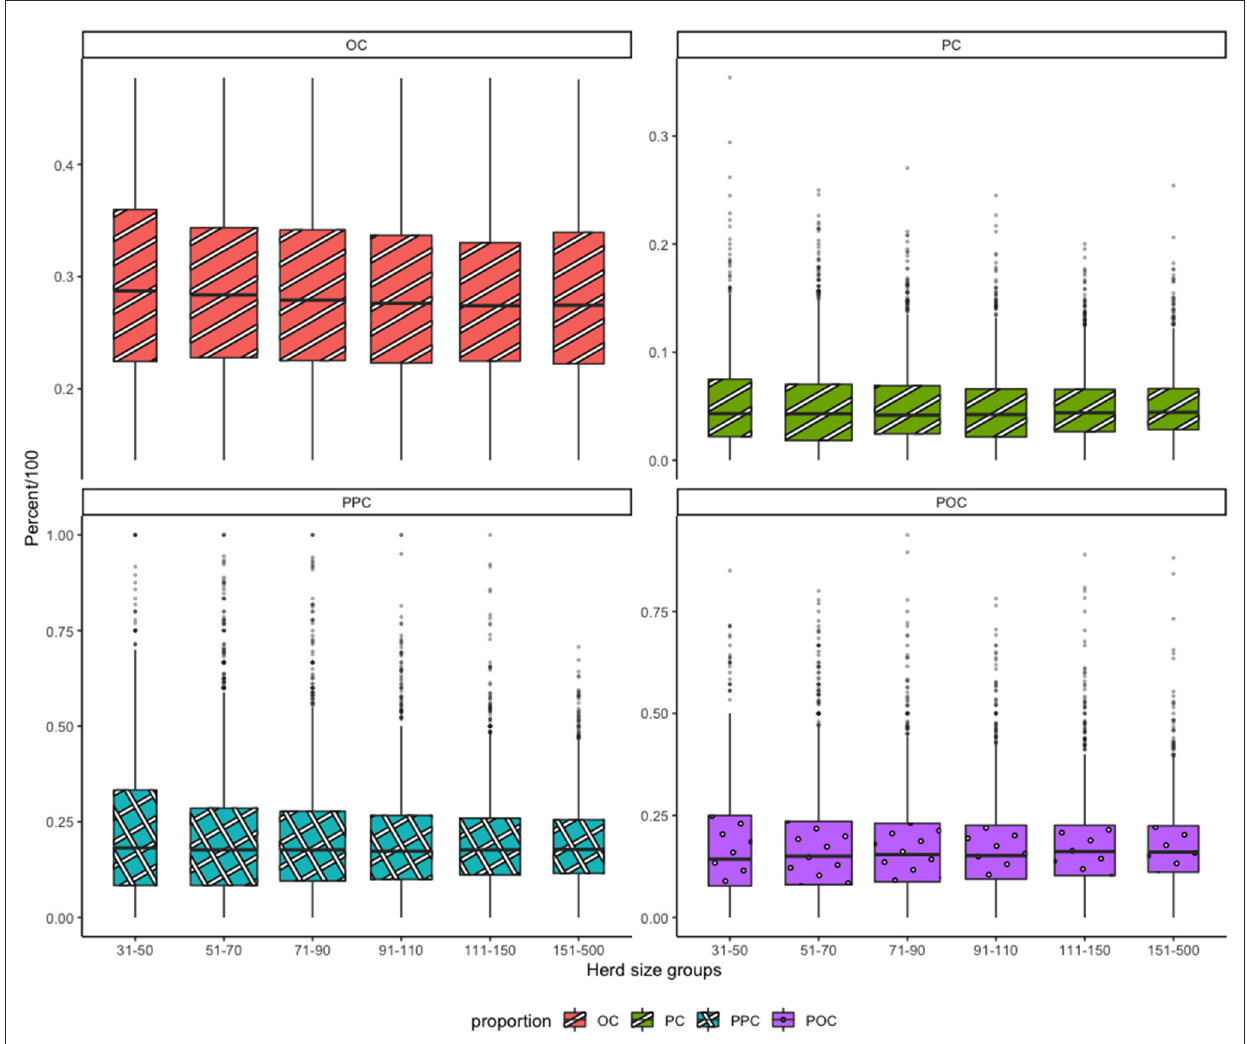
FIGURE1 Distribution of culling proportions across herd size groups. . OC, overall culling proportion; PC, primiparous culling proportion; PPC, primiparous-primiparous culling proportion; POC, primiparous-overall culling proportion. Herd size groups (x-axis) represent the number of producing cows in the farms in